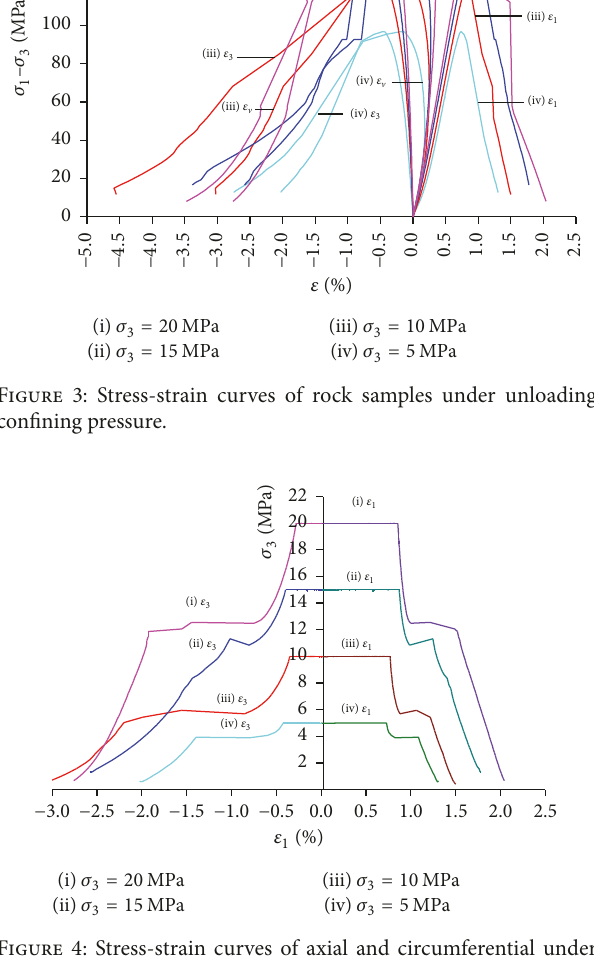
Figure 4: Stress-strain curves of axial and circumferential under different initial confining